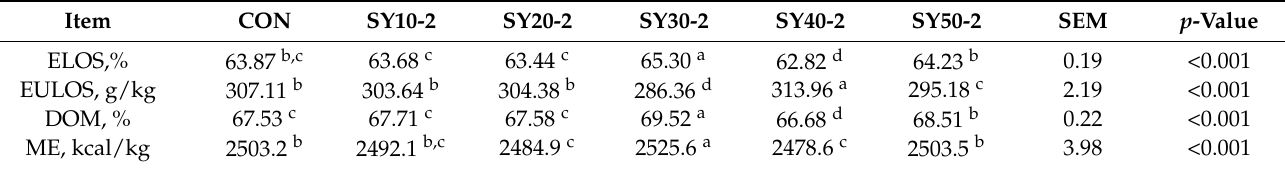
Table 6. In vitro digestibility and ME contents of corn silages (in DM).